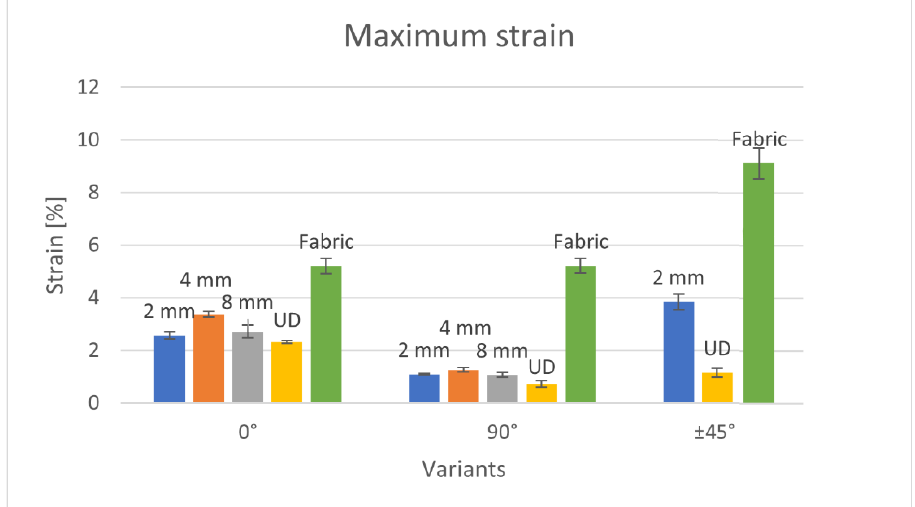
Figure 6. The strain of the produced composites.